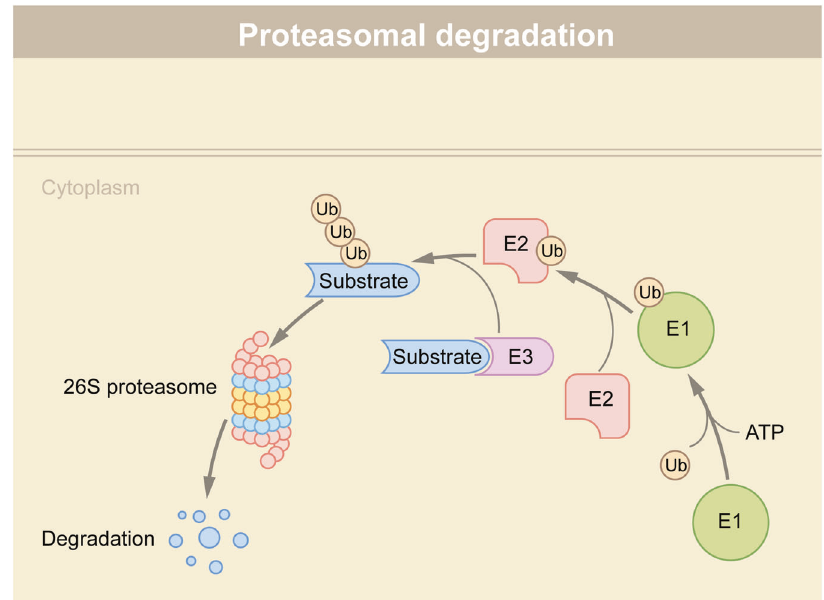
Fig. 1 Protein degradation via the ubiquitin-proteasome system (UPS). Proteins undergo ubiquitin-dependent degradation by a suite of three enzymes. E1 interacts with E2, and transfers the ubiquitin molecule to E2. E2 interacts with E3-binding substrate and transfers the ubiquitin molecule to the substrate. Repetition of these processes results in polyubiquitination of the substrate, which is subsequently degraded by the 26S proteasome